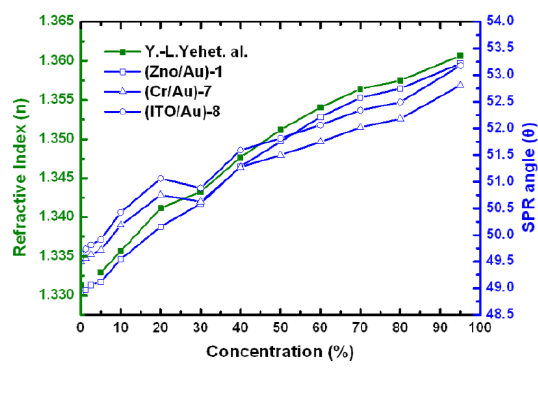
Figure 6. Comparison of the linear relationships between concentrations and refractive index and between concentrations and SPR